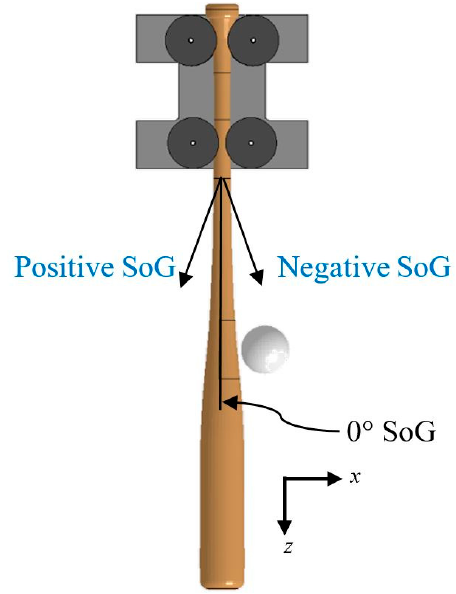
Figure 3. Finite element model of a baseball and the bat in the test fixture. The annotations denote the directions of positive, negative and 0° SoGs.